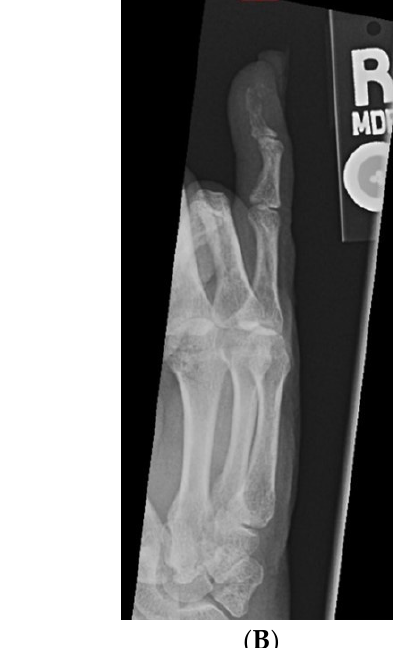
Figure 2. ( A , B ): AP and oblique radiographs of the right hand demonstrating lytic destruction and pathologic fracture of the distal phalanx of the small finger.